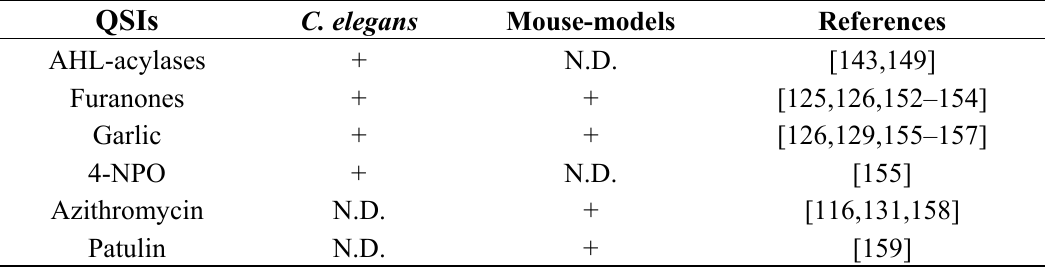
Table 2. Natural and synthetic quorum sensing inhibitors tested in C. elegans and mouse-models. (N.D.): Not